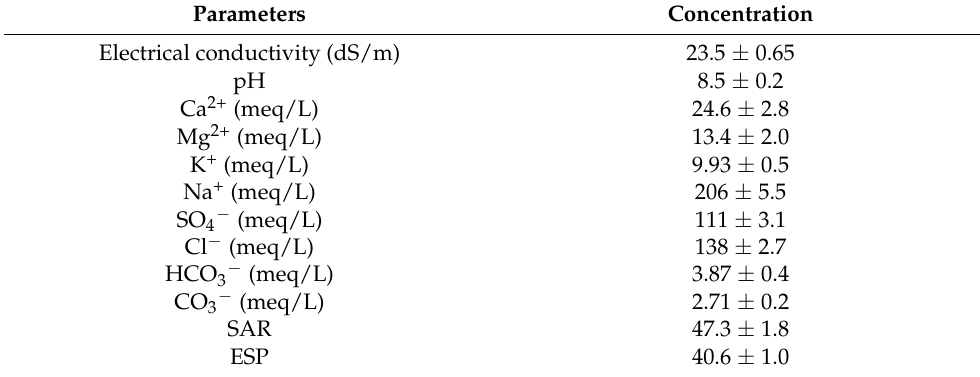
Table 1. Salinity characterization of the root soil of S. verrucosum measured in a saturated paste extract.